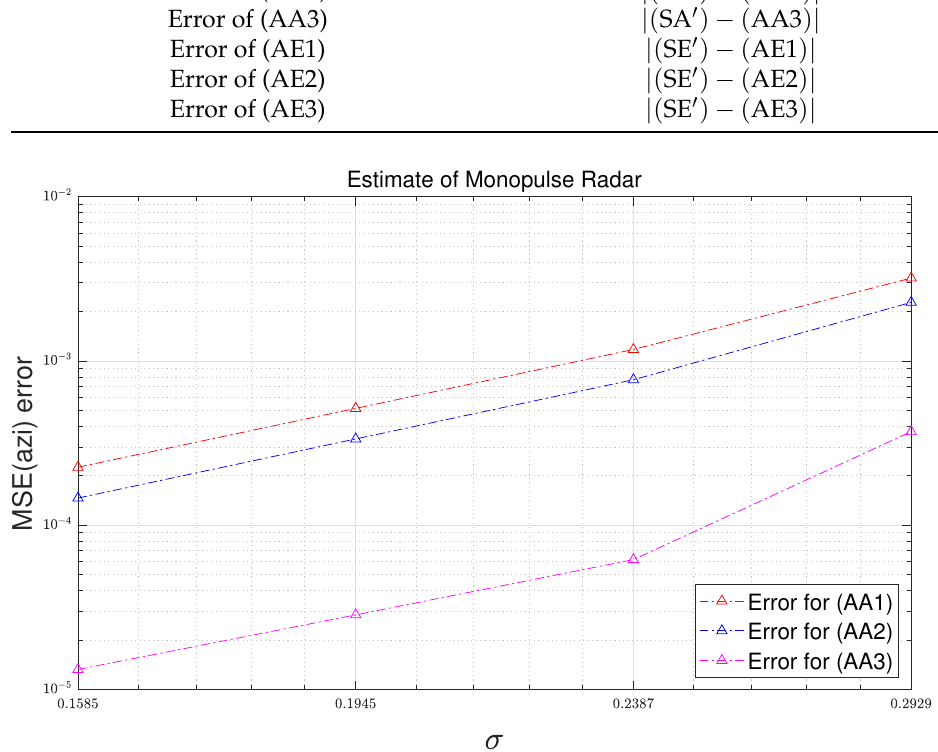
Figure 11. Azimuth MSE errors of analytic MSE as function of standard